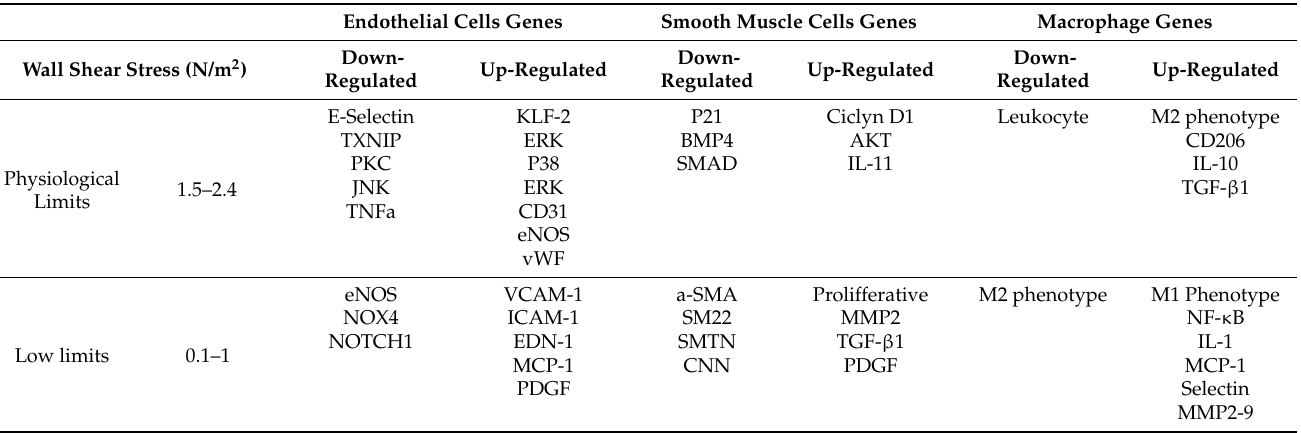
Table 3. Effect pf baseline and low WSS over endothelial cells, smooth muscle cells, and macrophages gene expression. Endothelial Cells Genes Smooth Muscle Cells Genes Macrophage